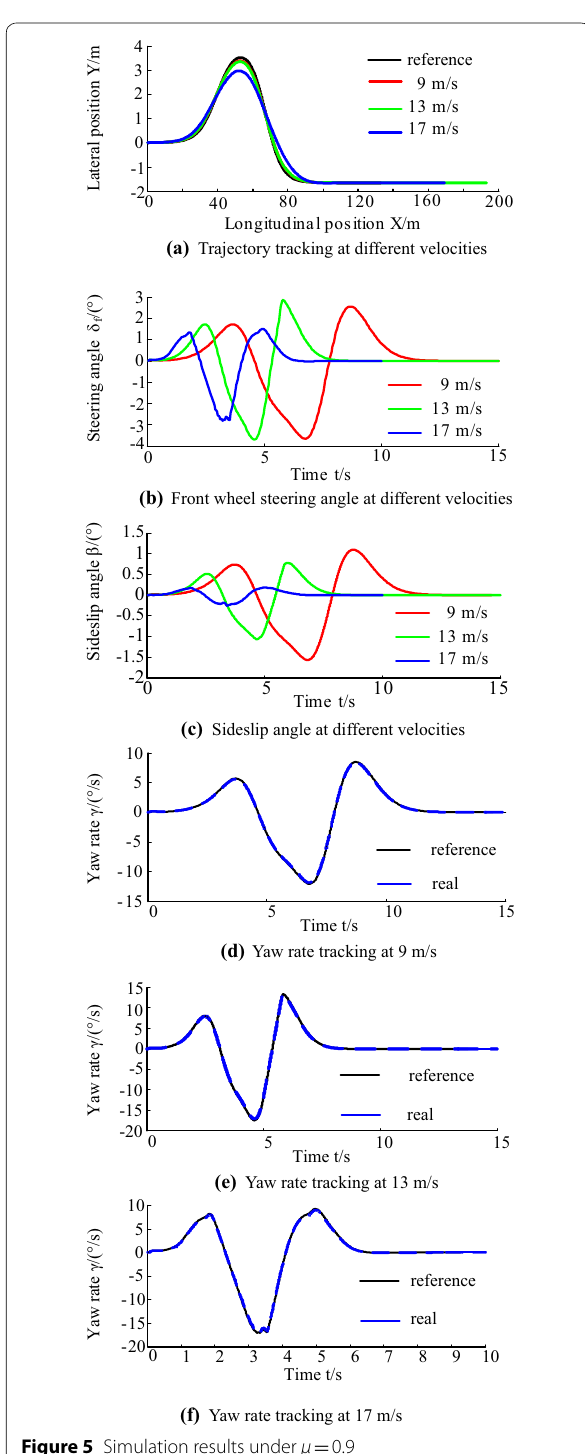
Figure 5 Simulation results under μ